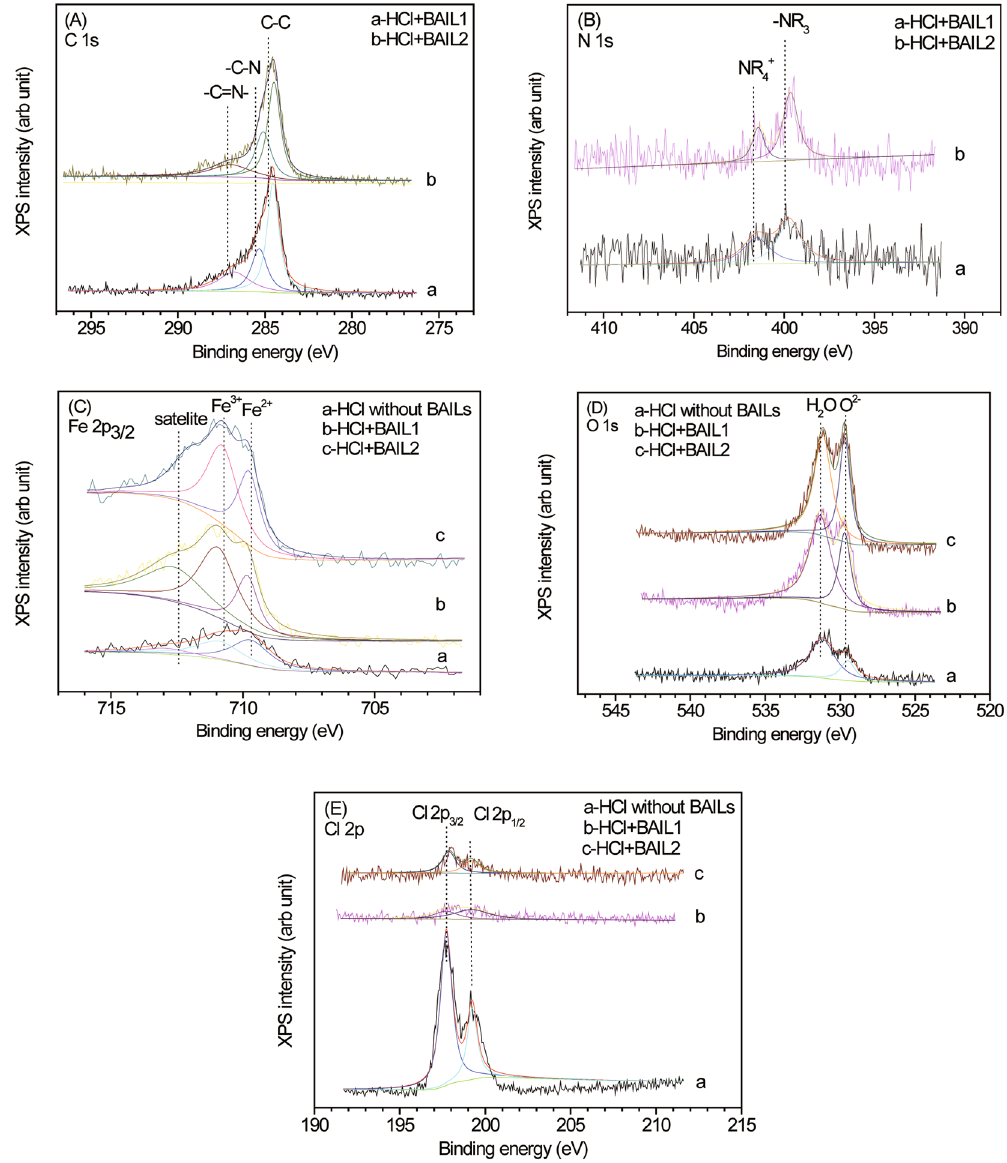
Figure 7. XPS spectra for carbon steel immersed in 0.5 M HCl solution without/with 0.75 mM BAILs after electrochemical experiments: ( A ) C 1 s; ( B ) N 1 s; ( C ) Fe 2p3/2; ( D ) O 1 s; ( E ) Cl